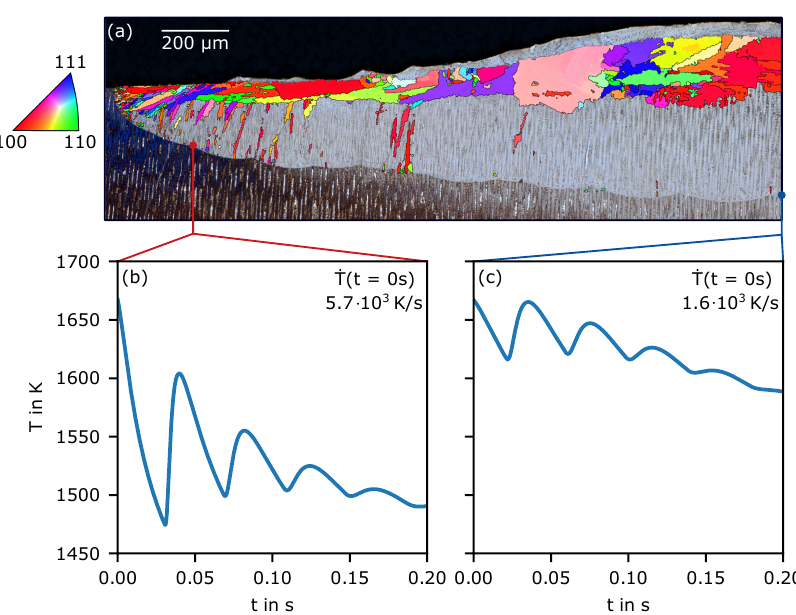
Figure 5. ( a ) Microsection with EBSD overlay for the hatched sample over the first 2mm perpendicular to the beam movement. The EBSD signal of the SX substrate was removed. ( b , c ) show the temporal evolution of the temperature at the marked points in ( a ). ( b ) marks the point at the deepest melt-pool border where the first beam crosses the section. The same applies for ( c ) but at 2mm. The time after the temperature falls below the liquidus temperature for the first time after melting is shown only. Additionally, the cooling rates ˙ T at the beginning of solidification for both locations are depicted.